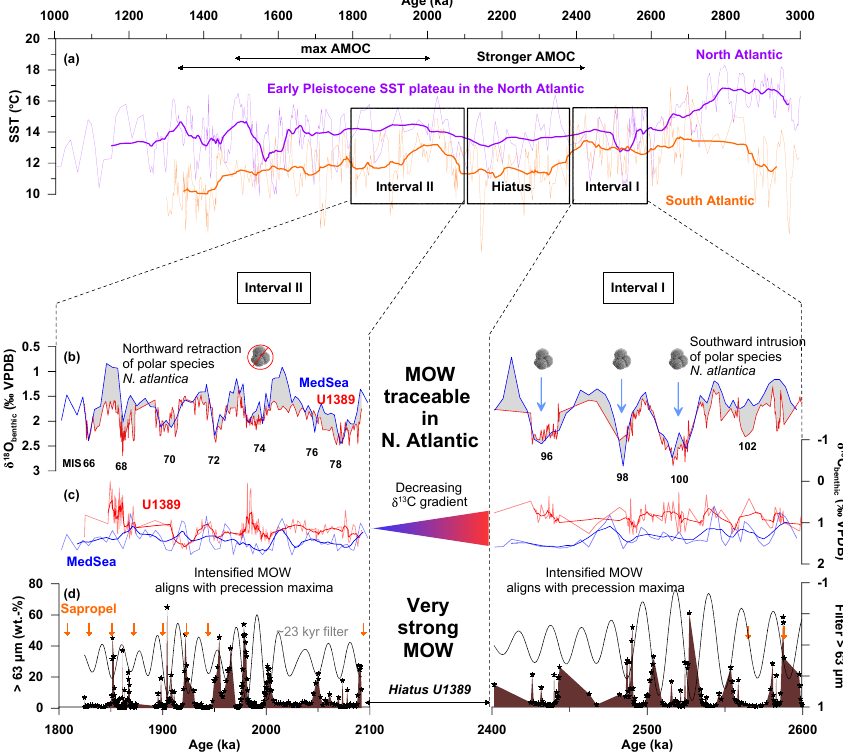
Figure 4. (a) UK 37 -based sea-surface temperature (SST) record of North Atlantic Site ODP 982 (Lawrence et al., 2009) and South Atlantic Site ODP 1090 (Martinez-Garcia et al., 2010). The running mean has a bandwidth of 23. AMOC phases are marked by black arrows and follow the chronology of Bell et al. (2015). (b) Benthic δ 18 O records of both investigated intervals at Site U1389. Interval I comprises the time frame of 2.6 to 2.4Ma and Interval II 2.1 to 1.8Ma. Isotopic gradient between both records is indicated by the grey-shaded area. (c) Comparison of δ 13 C of P. ariminensis for both investigated intervals at Site U1389 and δ 13 C of the MedSea stack (Lourens et al., 1996a, unpublished data). The running means have a bandwidth of 5. The C. ungerianus -based δ 13 C values of the MedSea stack were adjusted to P. ariminensis δ 13 C values of Site U1389 following the interspecies correction presented in this study (d) Grain-size (63–150µm wt.%) records for both investigated intervals at Site U1389. The filtered ∼ 23kyr signal ( f = 0 . 05 ± 0 . 01) of the grain-size signal is indicated by the black dotted line. Sapropel mid-points are marked by orange arrows and follow the chronology of Emeis et al.